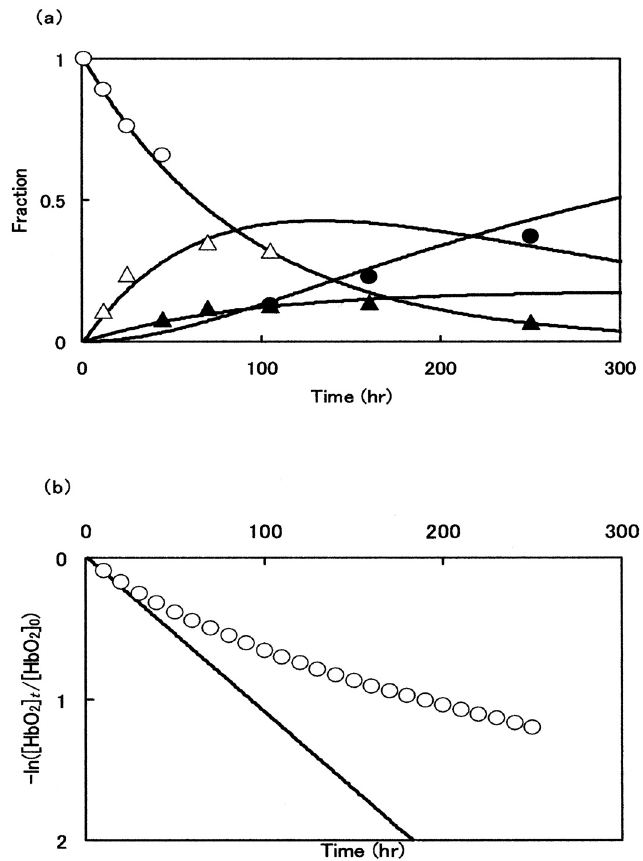
Figure 12. Outcomes achieved by a computer simulation using the consecutive reaction model with k , k , k , and k for human HbO 1 2 3 4 electrophoretic changes of the 1st ( ○ ), 2nd ( △ ), 3rd ( ▲ ) and 4th peaks ( ● ), respectively; and ( b ) the –ln([HbO ] /[HbO ] ) versus time plot (first-order plot). Solid lines 2 t 2 0